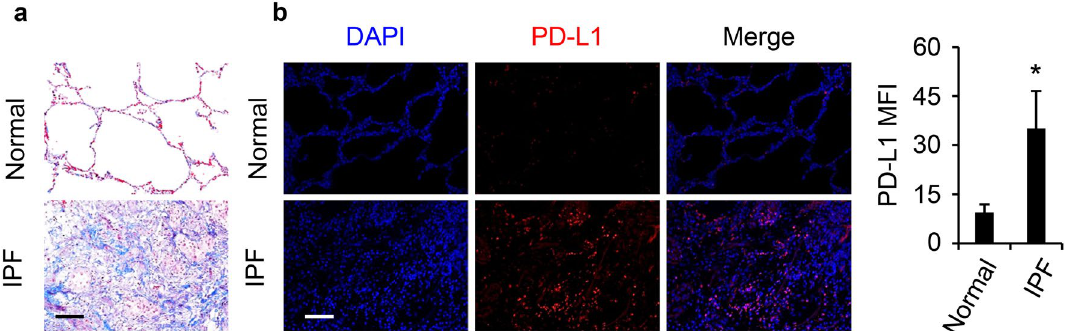
Figure 1. PD-L1 expression was increased in human IPF patients. ( a ) Representative images of Masson’s trichrome staining showed the remodeling of the lung and collagen deposition (blue) associated with IPF (n = 3/ group). ( b ) Representative immunofluorescence (IF) staining showed increased PD-L1 (red) levels in the lungs of IPF patients. DAPI stained the nuclei (blue). Bars (black and white) represent 100 µm. The quantification and comparison of PD-L1 mean fluorescence intensity (MFI) was based on measurements from 10 representative fields per slide from each of three normal and IPF patients. *, P < 0.05 compared with normal